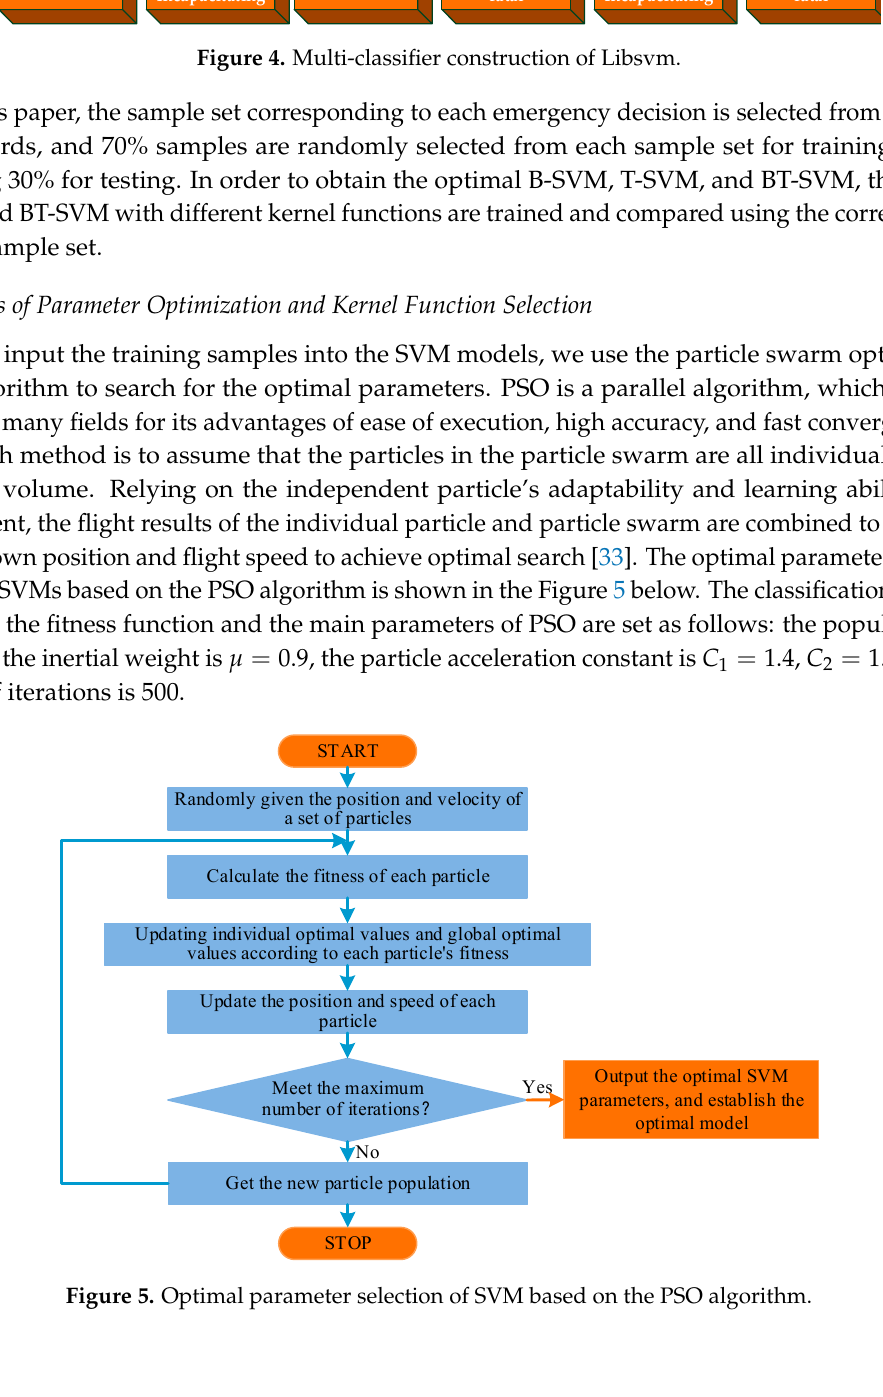
Figure 5. Optimal parameter selection of SVM based on the PSO algorithm.